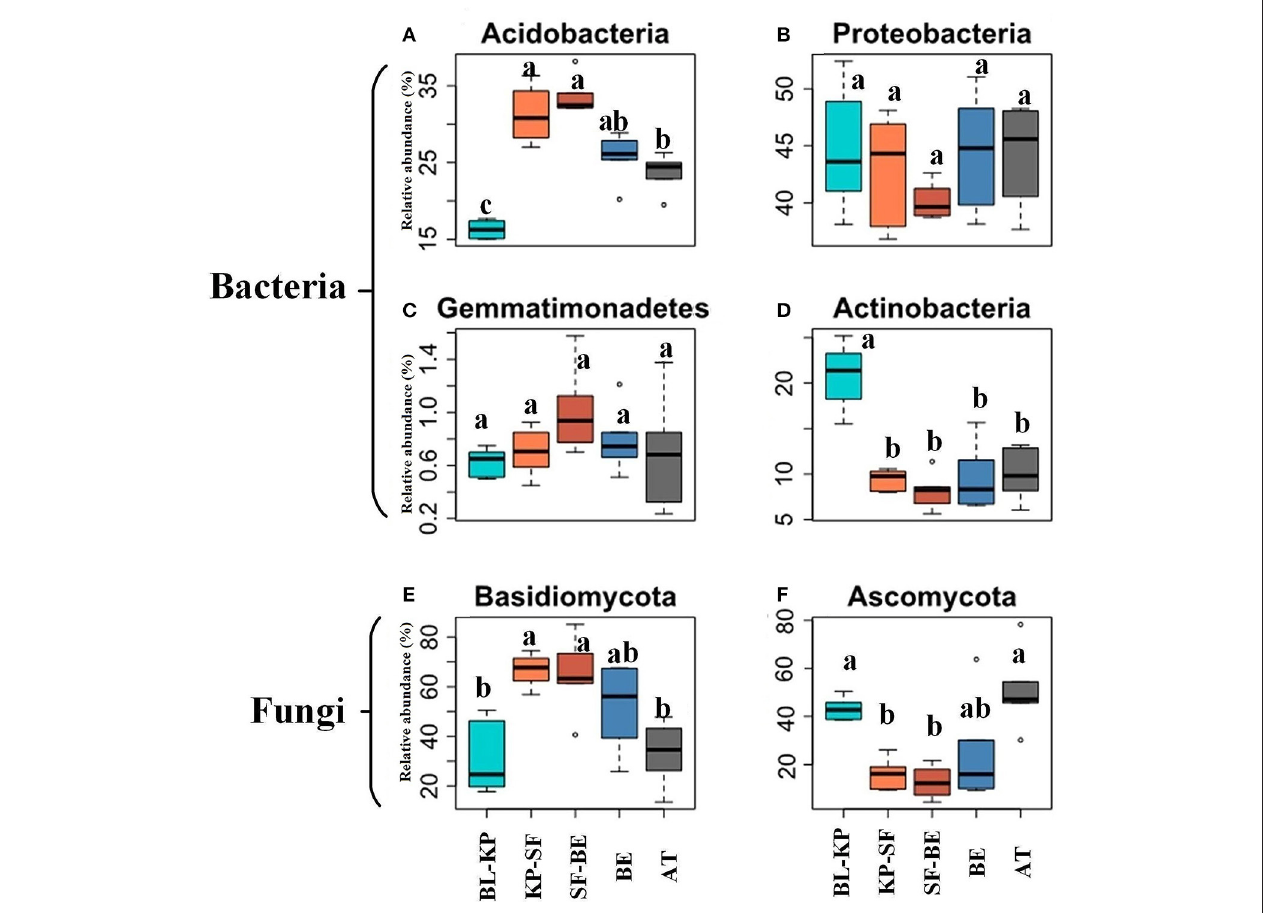
FIGURE 3 | The relative abundances of selected bacterial and fungal phyla along the elevational gradients. The bacterial phyla of Acidobacteria (A) and Gemmatimonadetes (C) , and fungal phylum of Basidiomycota (E) demonstrated highest relative abundances at mid-elevation, whereas the bacterial phyla of Proteobacteria (B) and Actinobacteria (D) , and fungal phylum of Ascomycota (F) showed lowest relative abundances at mid elevation (right panel). Significant differences ( t -test, P adjust < 0.05) among vegetation types are marked by different letters. BL-KP, Broad leaf-Korean pine mixed forest; KP-SF, Korean pine-spruce fir forest; SF-BE, Spruce Fir- Betula ermanii forest; BE, Betula ermanii forest; AT, Alpine